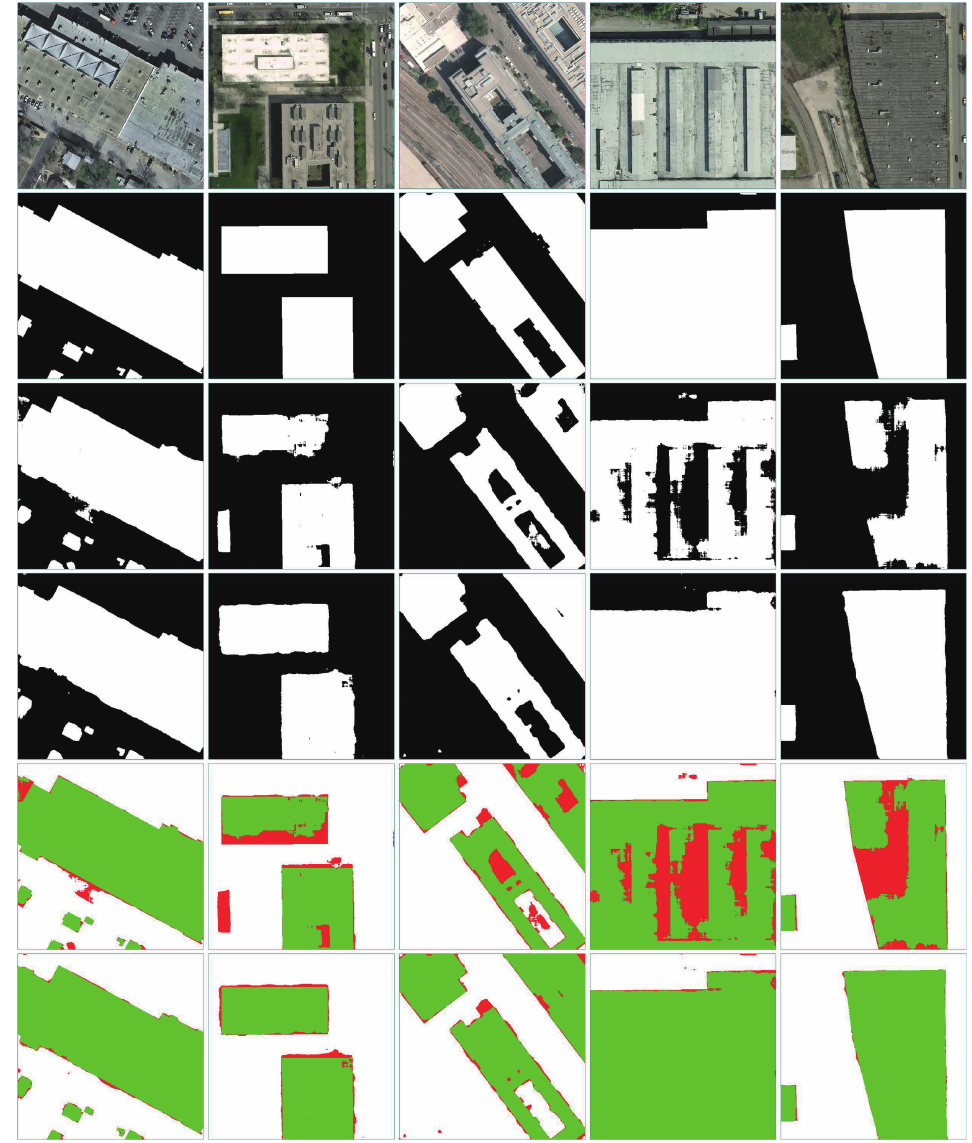
Figure 8. Examples of building extraction results produced by our method and U-Net on the Inria Aerial Image Labeling Dataset. The first two rows are aerial images and the ground truth. The predictions by U-Net and our method are in row 3 and row 4, respectively. The last two rows show the errors (wrongly predicted pixels are marked in red) of U-Net and our method,